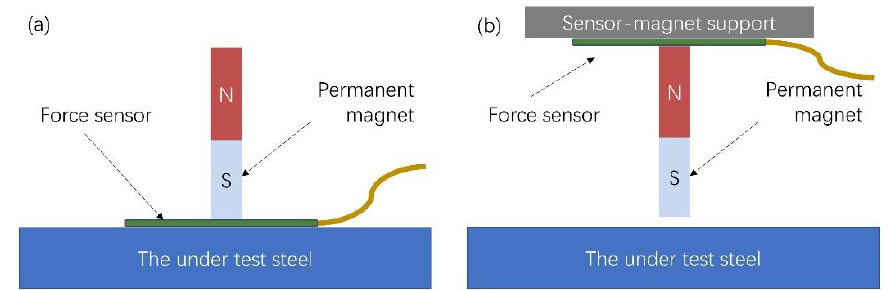
Figure 2. The schematic of the force sensor: ( a ) The force sensor is between the permanent magnet